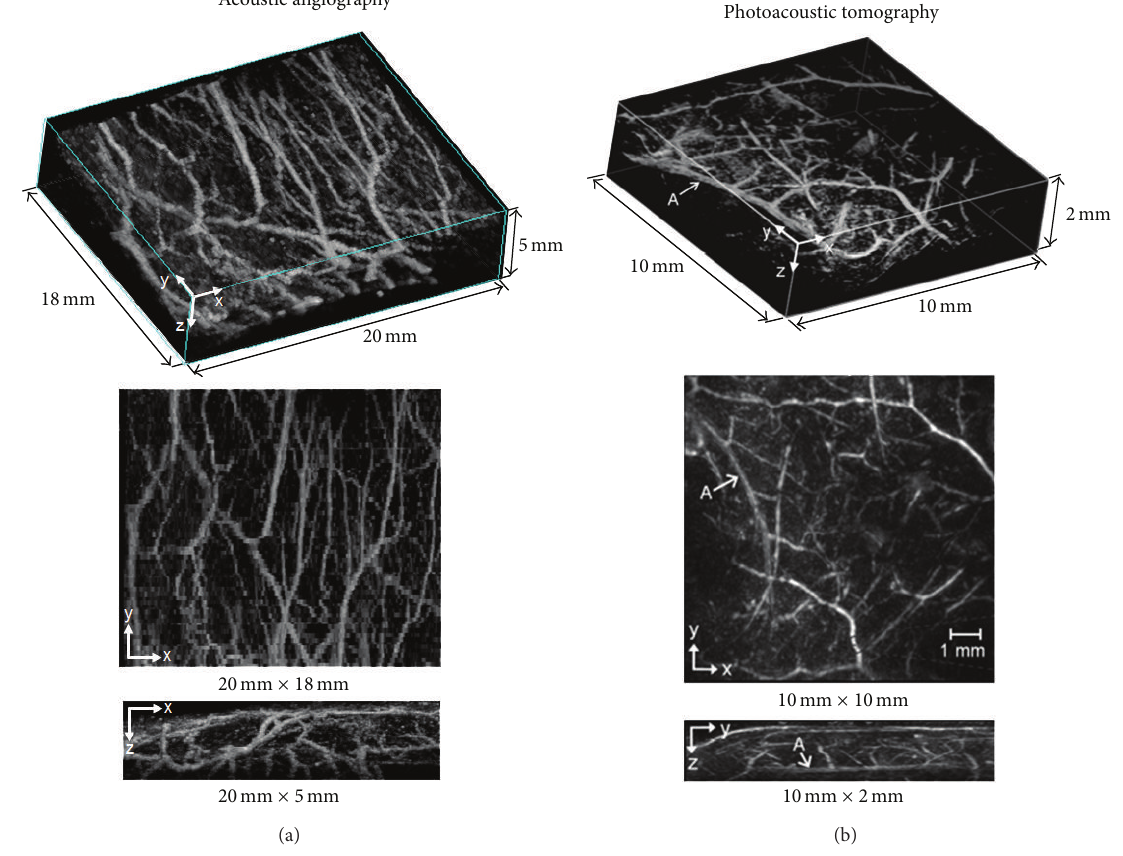
Figure 7: Comparison of acoustic angiography (a) to a photoacoustic imaging approach (b). The orientations of the acoustic angiography images have been purposefully arranged to mimic the photoacoustic images (adapted, with permission, from authors [20]) to allow a quick comparison between the two modalities. The imaging location of the acoustic angiography image was similar to that presented in Figure